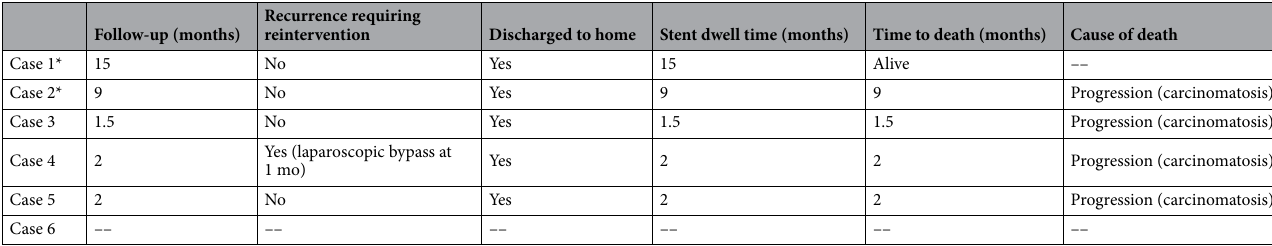
Table 2. Follow-up of patients undergoing EUS-guided anastomosis without involvement of the gastric wall.